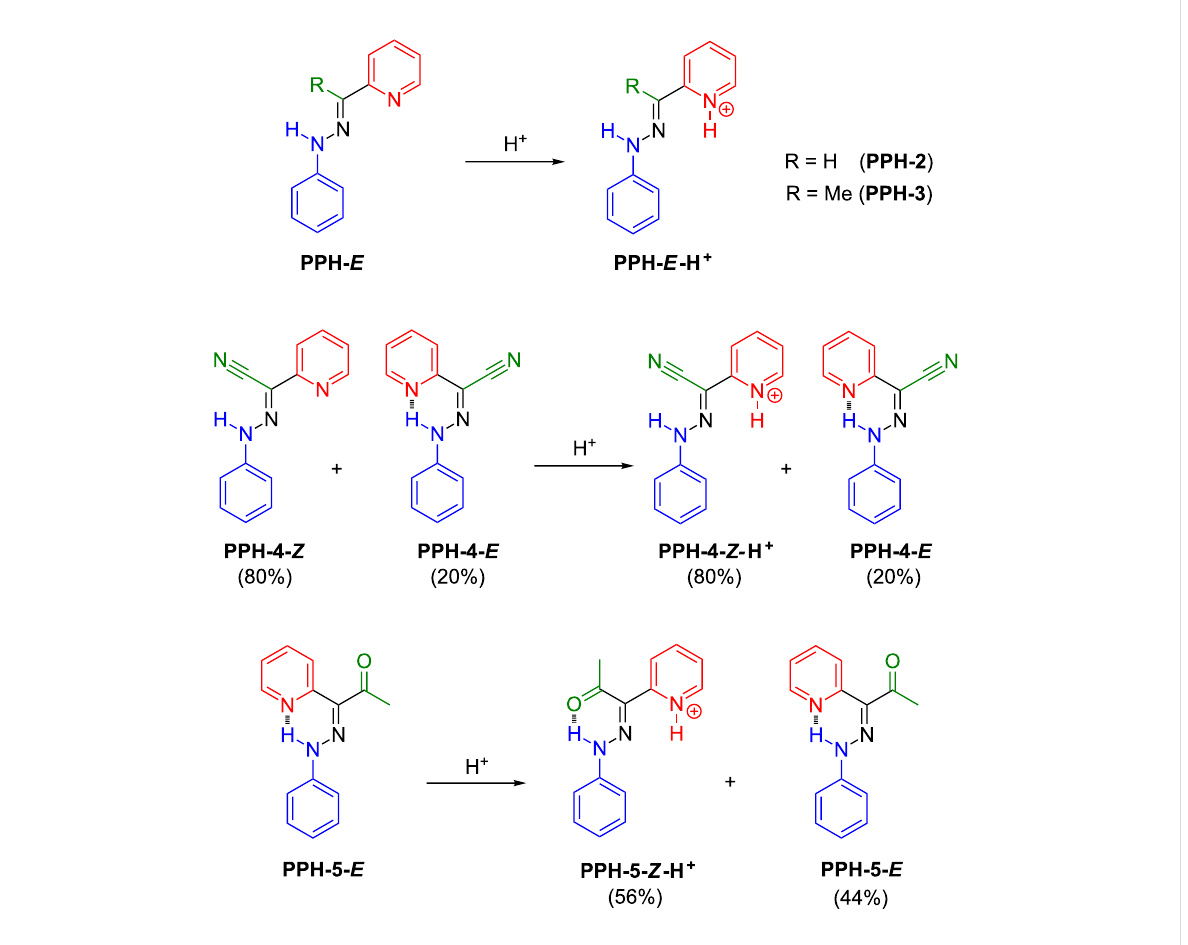
Scheme 2: The hydrazone-based molecular systems that were analysed in this paper, each having different rotors. The stable isomer(s) in solution and their protonation products are shown.